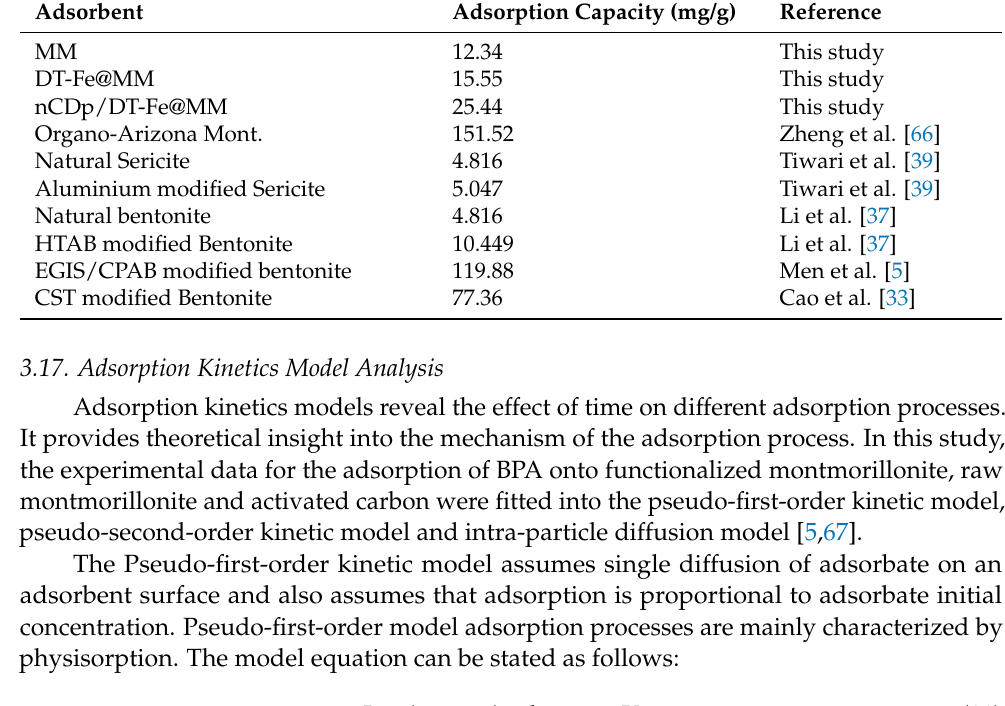
Table 3. Summary of BPA adsorption capacity of the adsorbents as compared to those in literature.